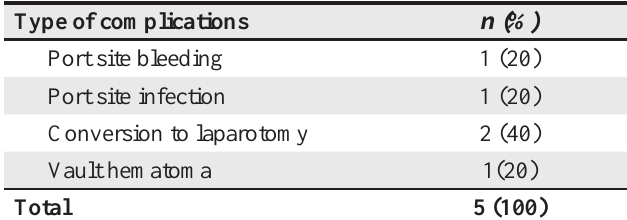
Table 4 : Complications of laparoscopic